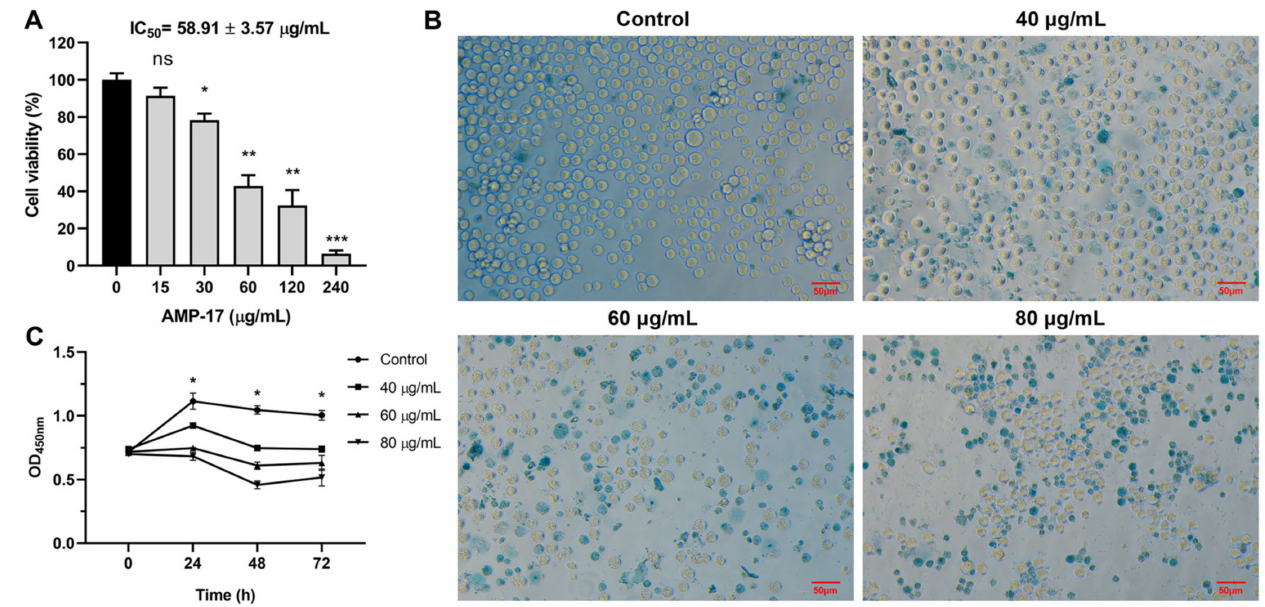
Figure 1. AMP-17 showed antitumor activity against K562 cells. ( A ) Cell viability of AMP-17 against K562 cells was determined using the CCK-8 assay (* p < 0.05, ** p < 0.01, *** p < 0.001, ns: not significant). The assay was performed in triplicate and repeated three times. ( B ) Trypan blue stained images of K562 cells treated with or without AMP-17. Images were captured using a 40 × power field. Scale bar, 50 µ m. ( C ) Cell proliferation of K562 cells treated with AMP-17 (40, 60 and 80 µ g/mL) for 24, 48, and 72 h was determined using the CCK-8 assay. (* p < 0.05). The assay was repeated three times